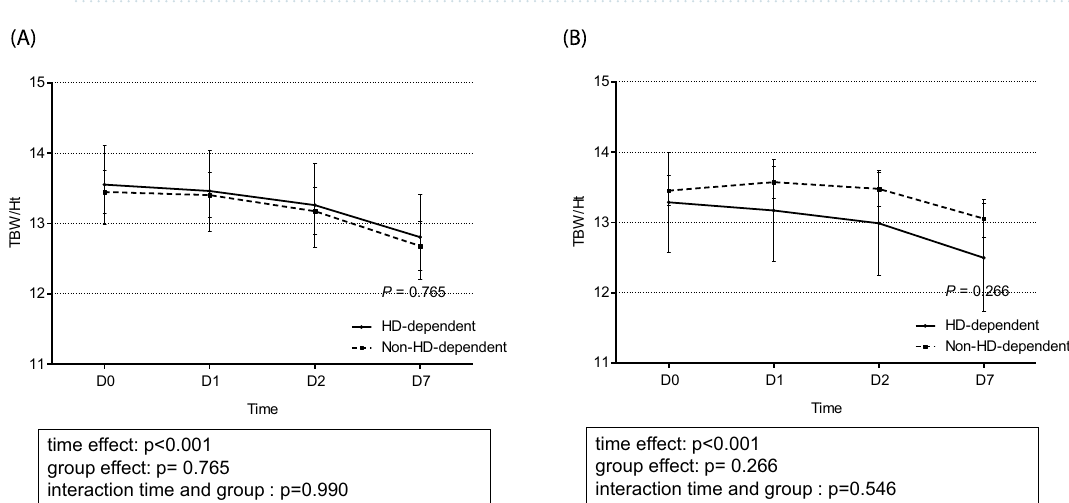
Figure 4. Comparison of the change in body weight estimates between the mortality and alive groups. ( A ) Univariate and ( B ) multivariate mixed-effect linear regression analyses are shown. The mixed-effects linear regression analysis between the two groups included the association with volume status at CRRT initiation, adjusted for age, sex, age-modified CCI, DM, hypertension, SOFA score, urine output for 6 h, and serum albumin level, MDRD, and eGFR at CRRT initiation.